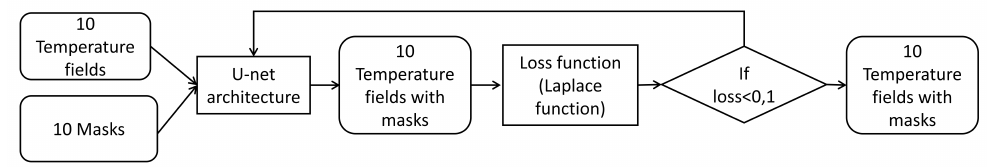
Figure 2. The physics-driven training approach. One batch has ten layout